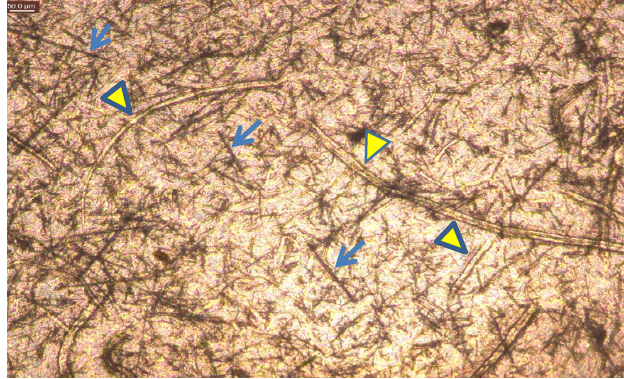
Figure 5. Cellulose matrices for material integration. Cellulose and CuHARS together. Dark, straight structures are CuHARS (blue arrows), and light, curved structures are cellulose fibers (yellow arrowheads). Image obtained using inverted light microscopy, with a 50 micron scale bar indicated (top left of image).